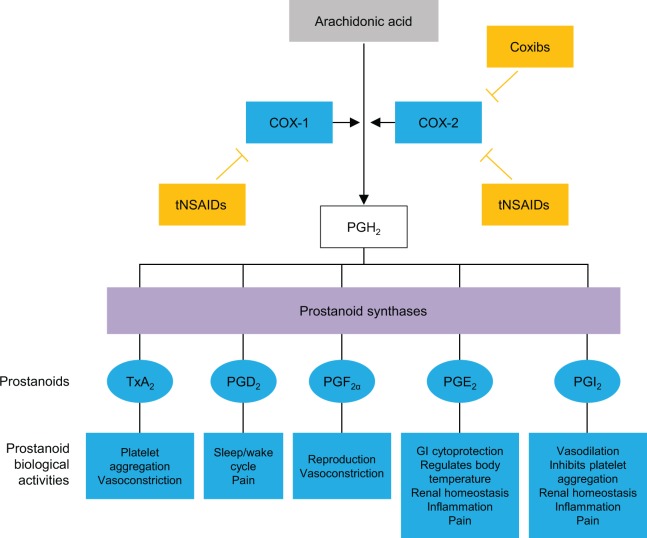
Mechanisms of action of traditional and COX-2-selective NSAIDs. Adapted from Brune and Patrignani.37 COX indicates cyclooxygenase; Coxibs, COX-2 inhibitors; GI, gastrointestinal; NSAIDs, nonsteroidal anti-inflammatory drugs; PG, prostaglandin; PGI2, prostacyclin; tNSAIDs, traditional NSAIDs; TxA2, thromboxane.